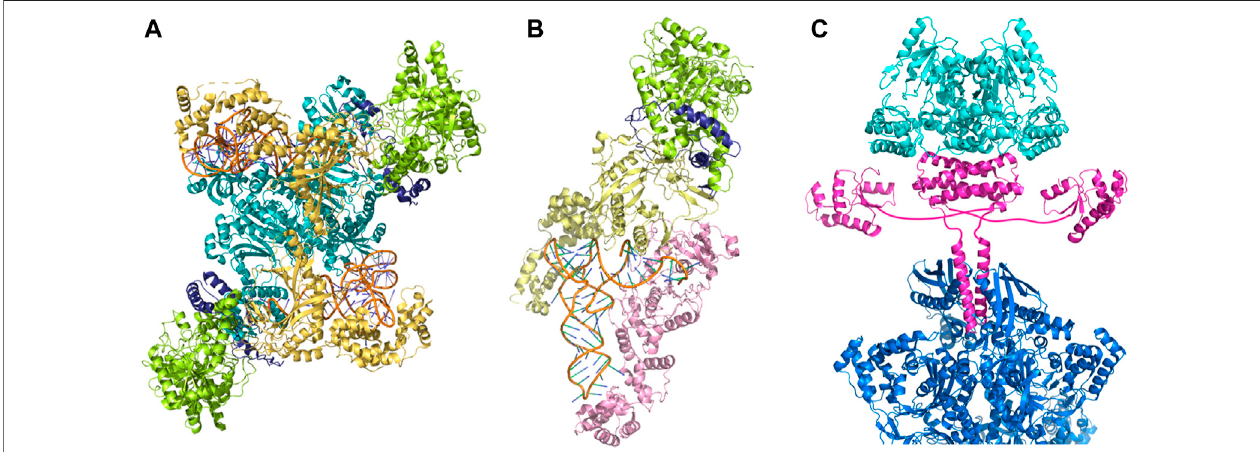
FIGURE 2 | Macromolecular complexes embody the indirect pathway to aminoacyl-tRNAs. (A) Asparaginyl-transamidosome from Pseudomonas aeruginosa (Suzuki et al., 2015) (PDB id: 4WJ3), (B) glutaminyl-transamidosome from Thermotoga maritima (Ito and Yokoyama, 2010) (PDB id: 3AL0), (C) a model of the transsulfursome from Methanocaldococcus jannaschii (Chen et al., 2017b) (PDB ids: 5X6B, 5X6C). Amidotransferase subunits are shown in light green (GatA), yellow (GatB), and dark blue (GatC); ND-AspRS is shown in teal, and ND-GluRS in light pink. One half of tetrameric SepRS is visible and shown in blue; SepCysS and SepCysE are shown in cyan and magenta,